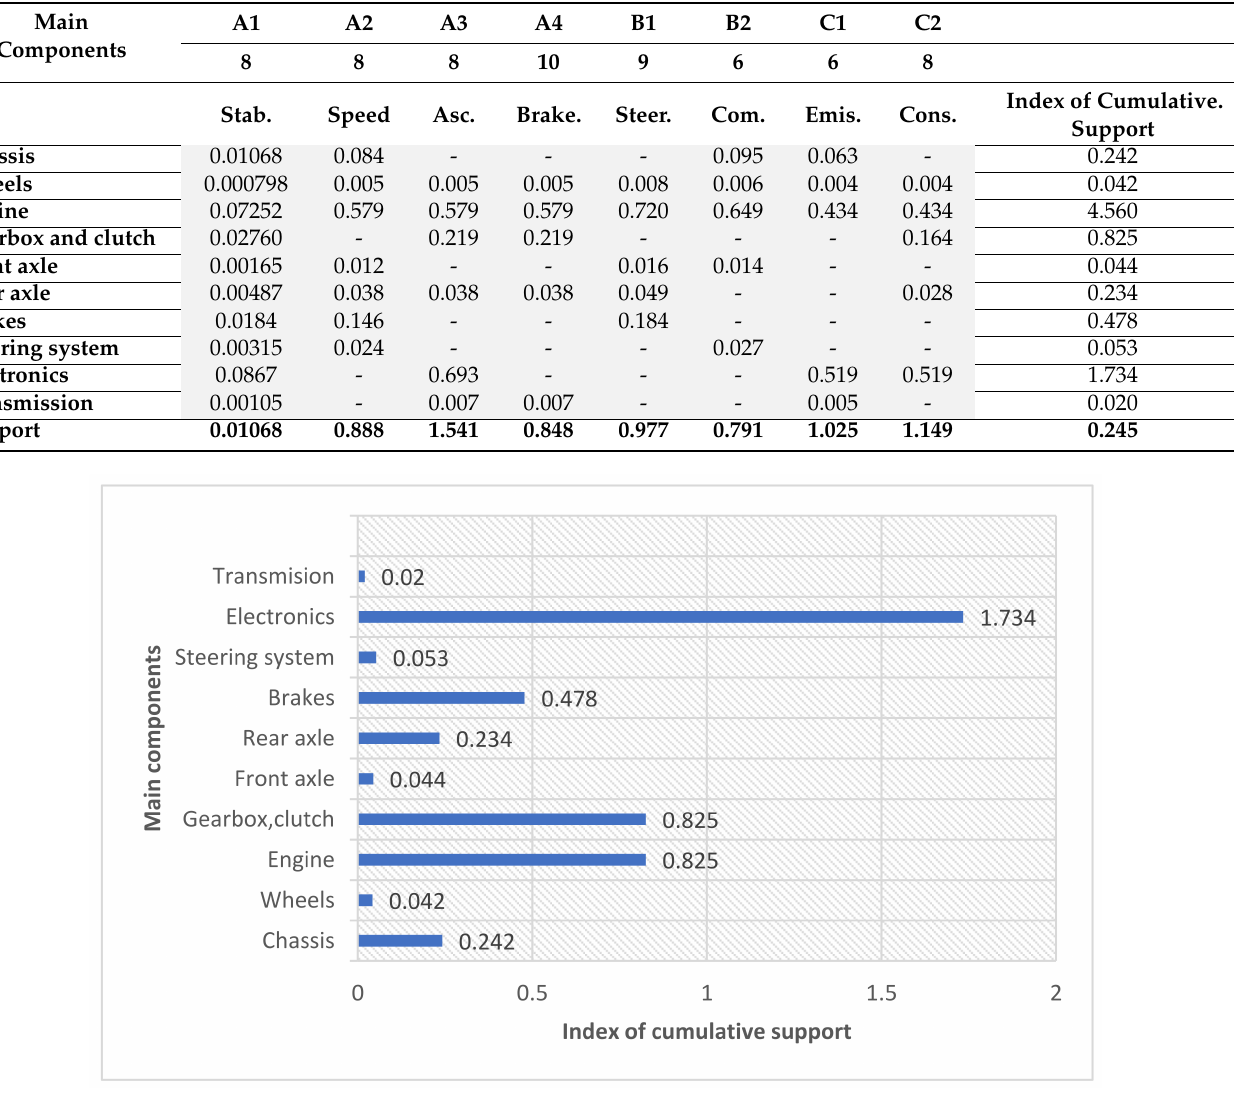
Figure 4. Support index for the main